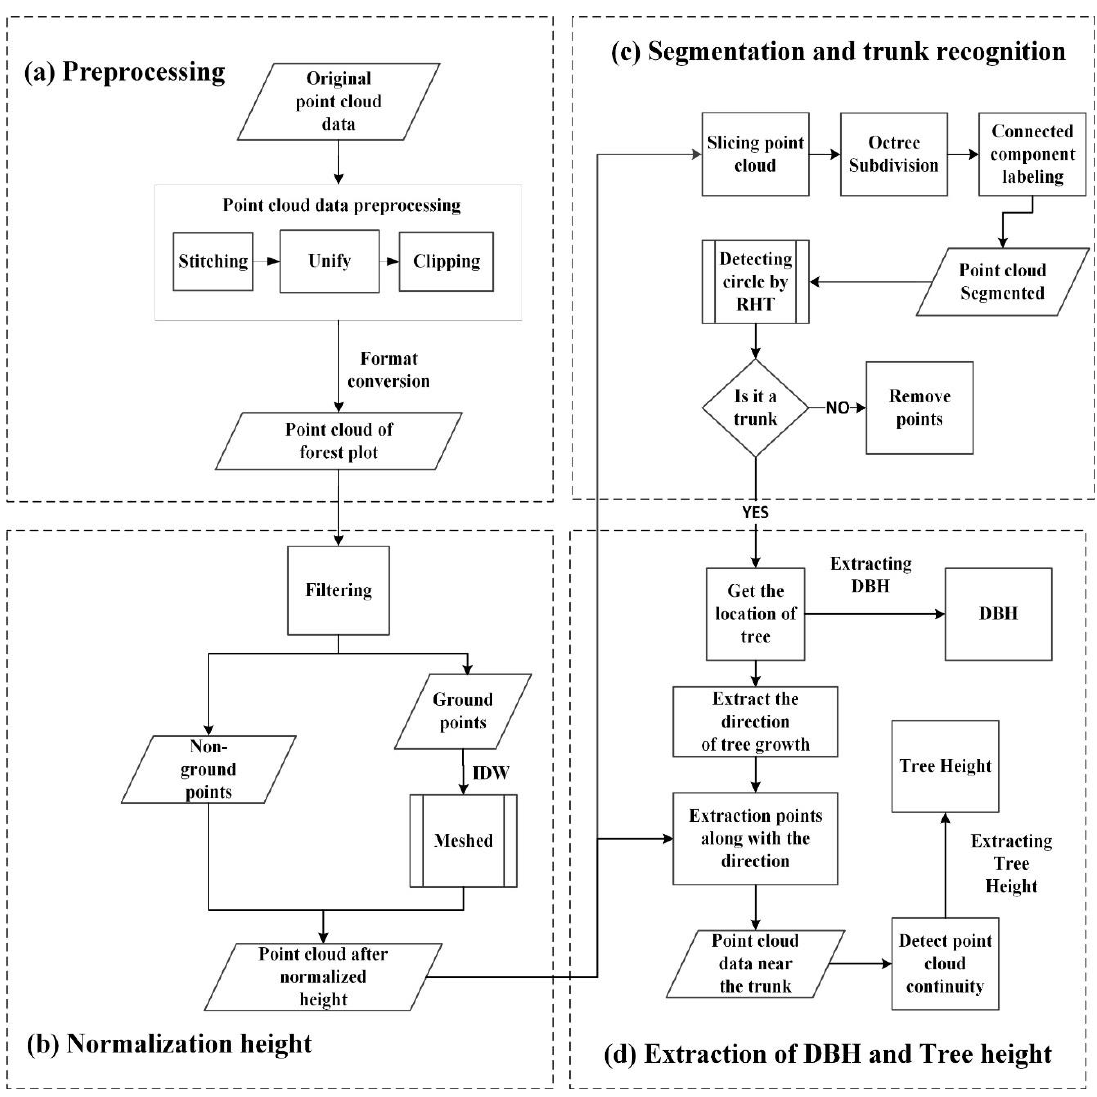
Figure 3. Flowchart detailing the methods in this study. ( a ) In order to remove useless data and reduce the amount of data, point cloud data needs to be preprocessed; ( b ) Normalization of points height facilitates the extraction of DBH and tree height; ( c ) The slicing and segmenting point clouds can improve the efficiency and accuracy of trunk recognition; ( d ) According to the trunk position, directly we extract or fit the DBH. Tree heights are obtained based on the tree growth direction and continuity detecting.